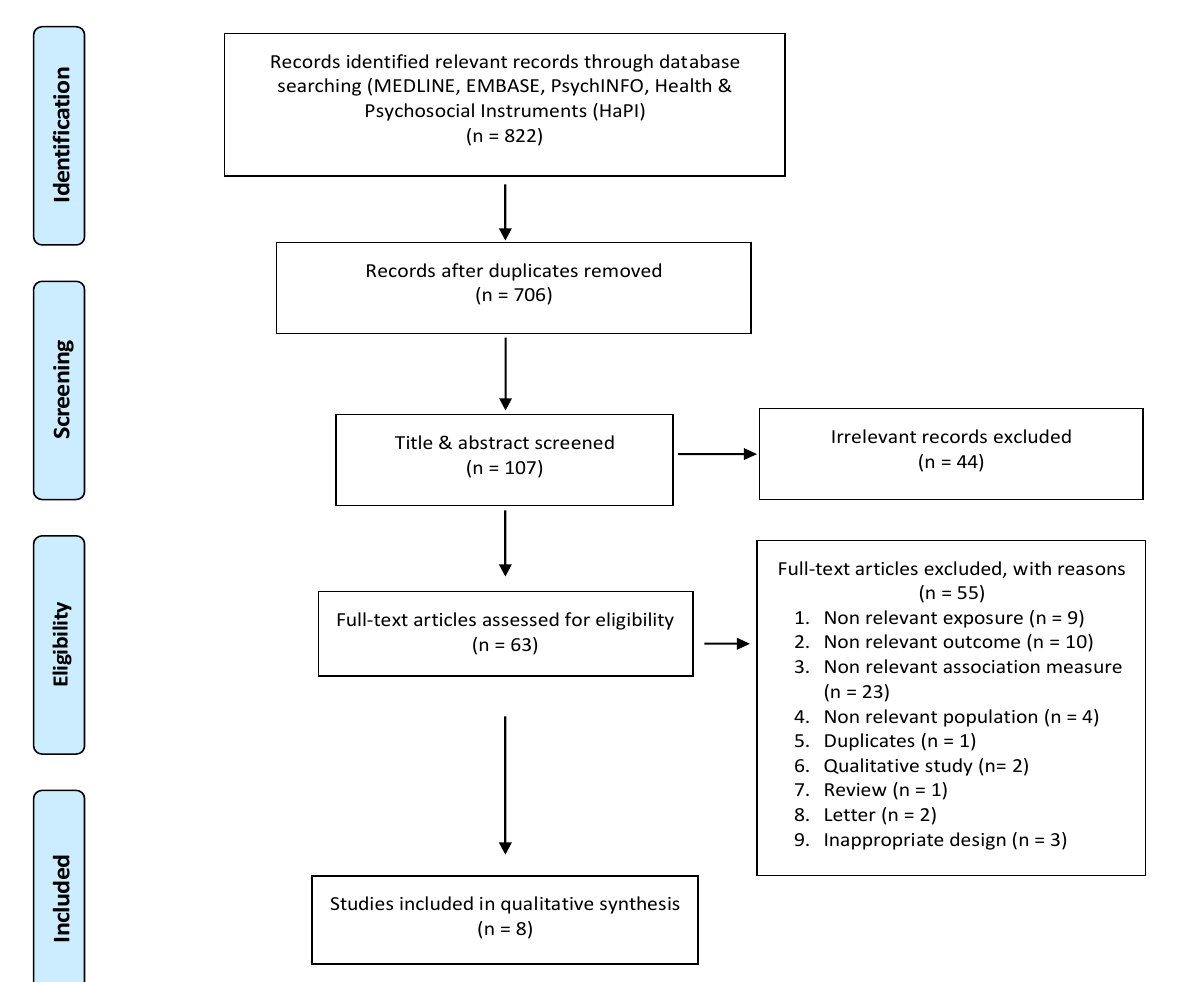
Figure 1. Flow diagram showing study selection for post-traumatic stress disorder (PTSD) related to coronavirus (CoV-1 and CoV-2) pandemics among healthcare professionals (HCPs).